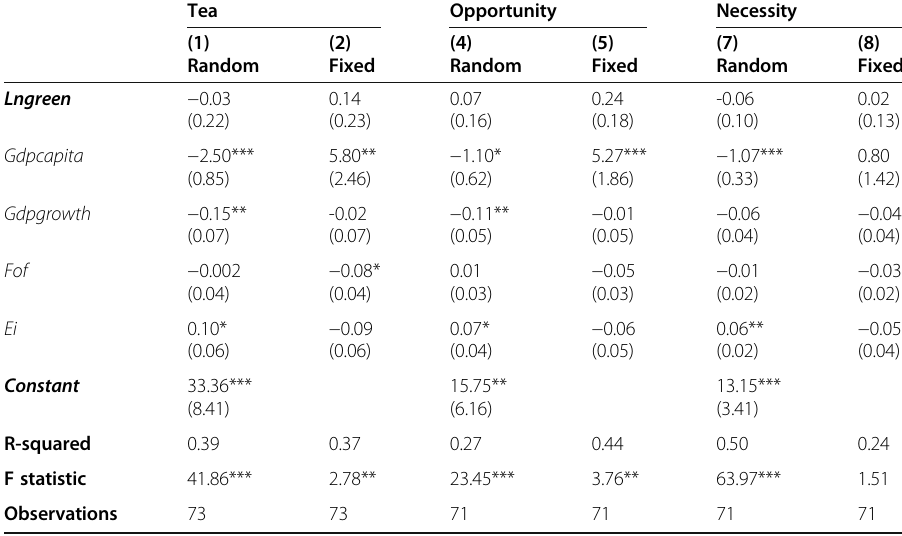
Table 5 Relationship between Greenfield investment and entrepreneurship during crisis Tea Opportunity